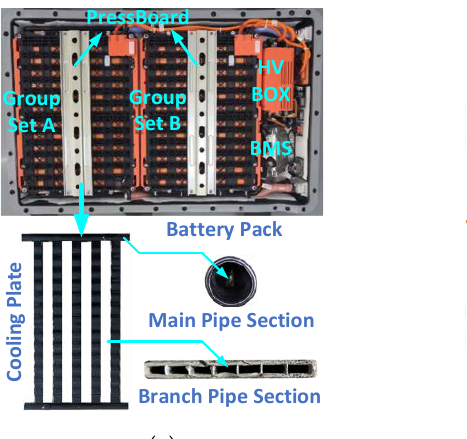
Figure 13. Battery pack with a cooling plate under a test: ( a ) the battery pack’s internal structure and the cooling plate in details; ( b ) the thermocouple placement and fixing method.